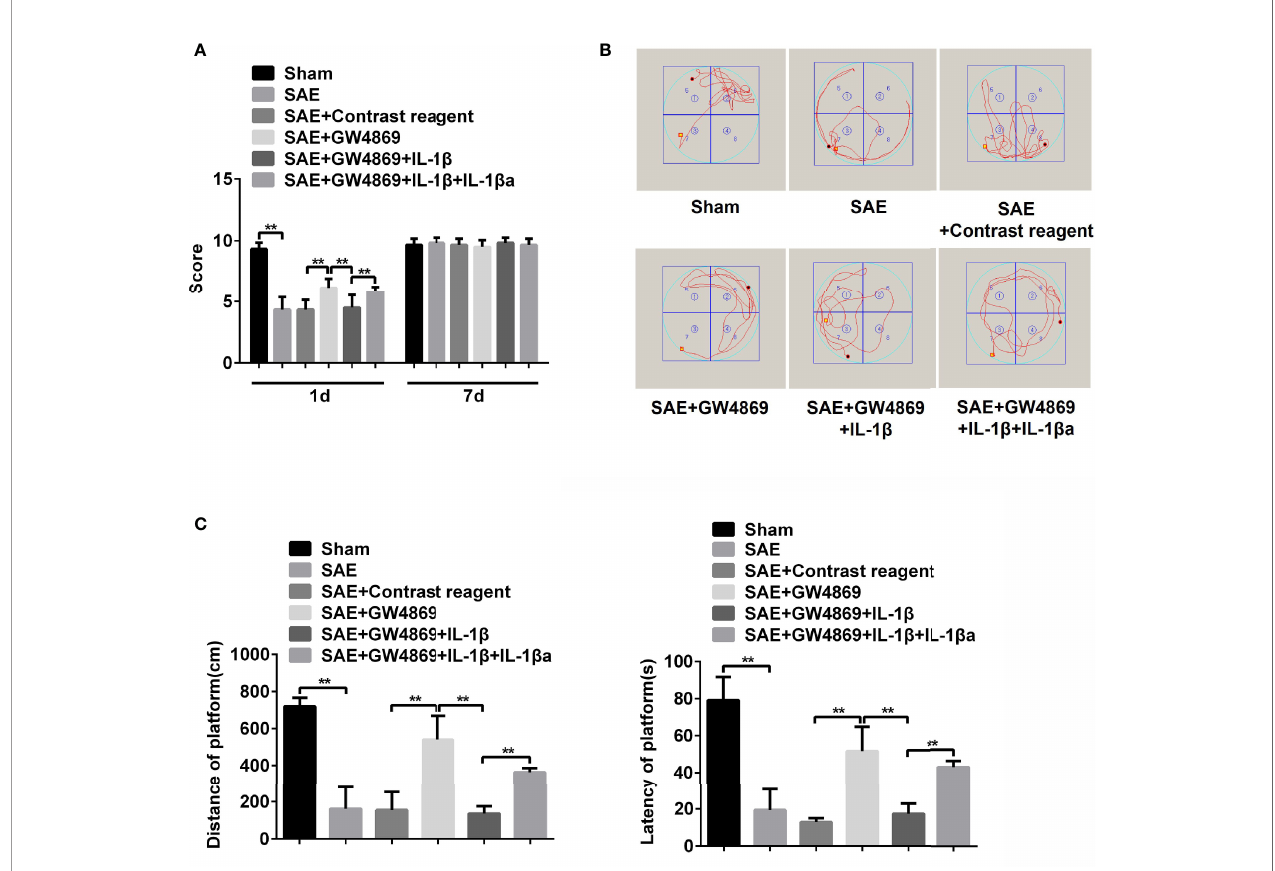
FIGURE 6 | Role of IL-1 b in memory impairment of SAE rats. (A) Rats were processed with Sham control surgery and CLP treatment. Then, the SAE rats were divided into fi ve groups: Sham, SAE, SAE treated with control reagent, SAE treated with IL-1 b , SAE treated with IL-1 b and IL-1 b antagonist. Then, neurological behavior score was measured. (B) Morris water maze was used to monitor the moving track of rats in the pool. (C) The distance and time percent on platform were recorded and calculated. **P <